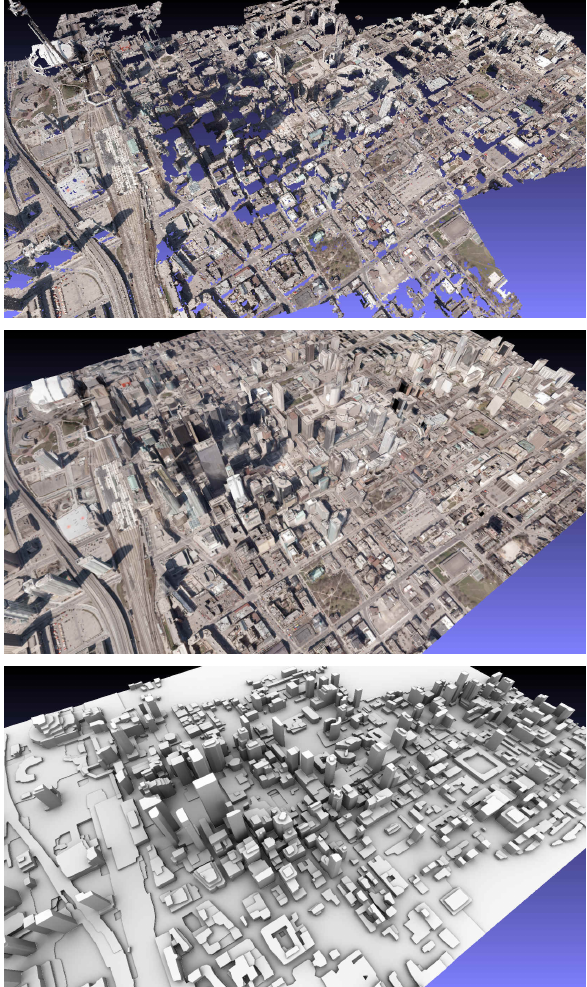
Figure 5. Results of the proposed approach on the Toronto dataset. Top: Original input point cloud containing noise, outliers, and large missing regions; Middle: The obtained 3D city model with filled regions and removed outliers; Bottom: The obtained untextured mesh as visualization of the pure